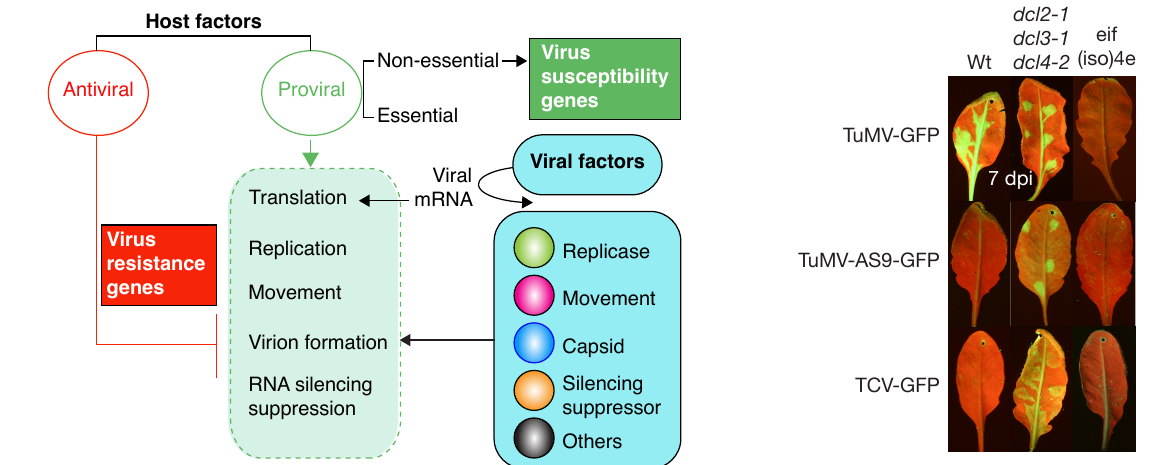
Figure 2. Functional groups of host and viral factors based on their role in virus infection. ( A ) Host factors may have antiviral or proviral activity. Antiviral factors (red line) condition resistance to virus infection by antagonizing one or more essential parts of the infection cycle (dotted green box). Proviral factors (green arrow) work in synchrony with viral factors in all parts of the infection cycle, determine virus susceptibility, and may be essential or nonessential to the host. ( B ) Gene silencing restricts virus infection and virus-encoded silencing suppressors are needed for infection. In the absence of translation initiation factor eIS(iso)4E, TuMV cannot infect A. thaliana . eIF(iso)4E is needed for potyvirus replication and/or cell-to-cell movement. A. thaliana leaves were mechanically inoculated with TuMV-GFP, suppressor deficient TuMV-AS9-GFP, or suppressor deficient TCV-GFP. Pictures were taken at 7 dpi under UV